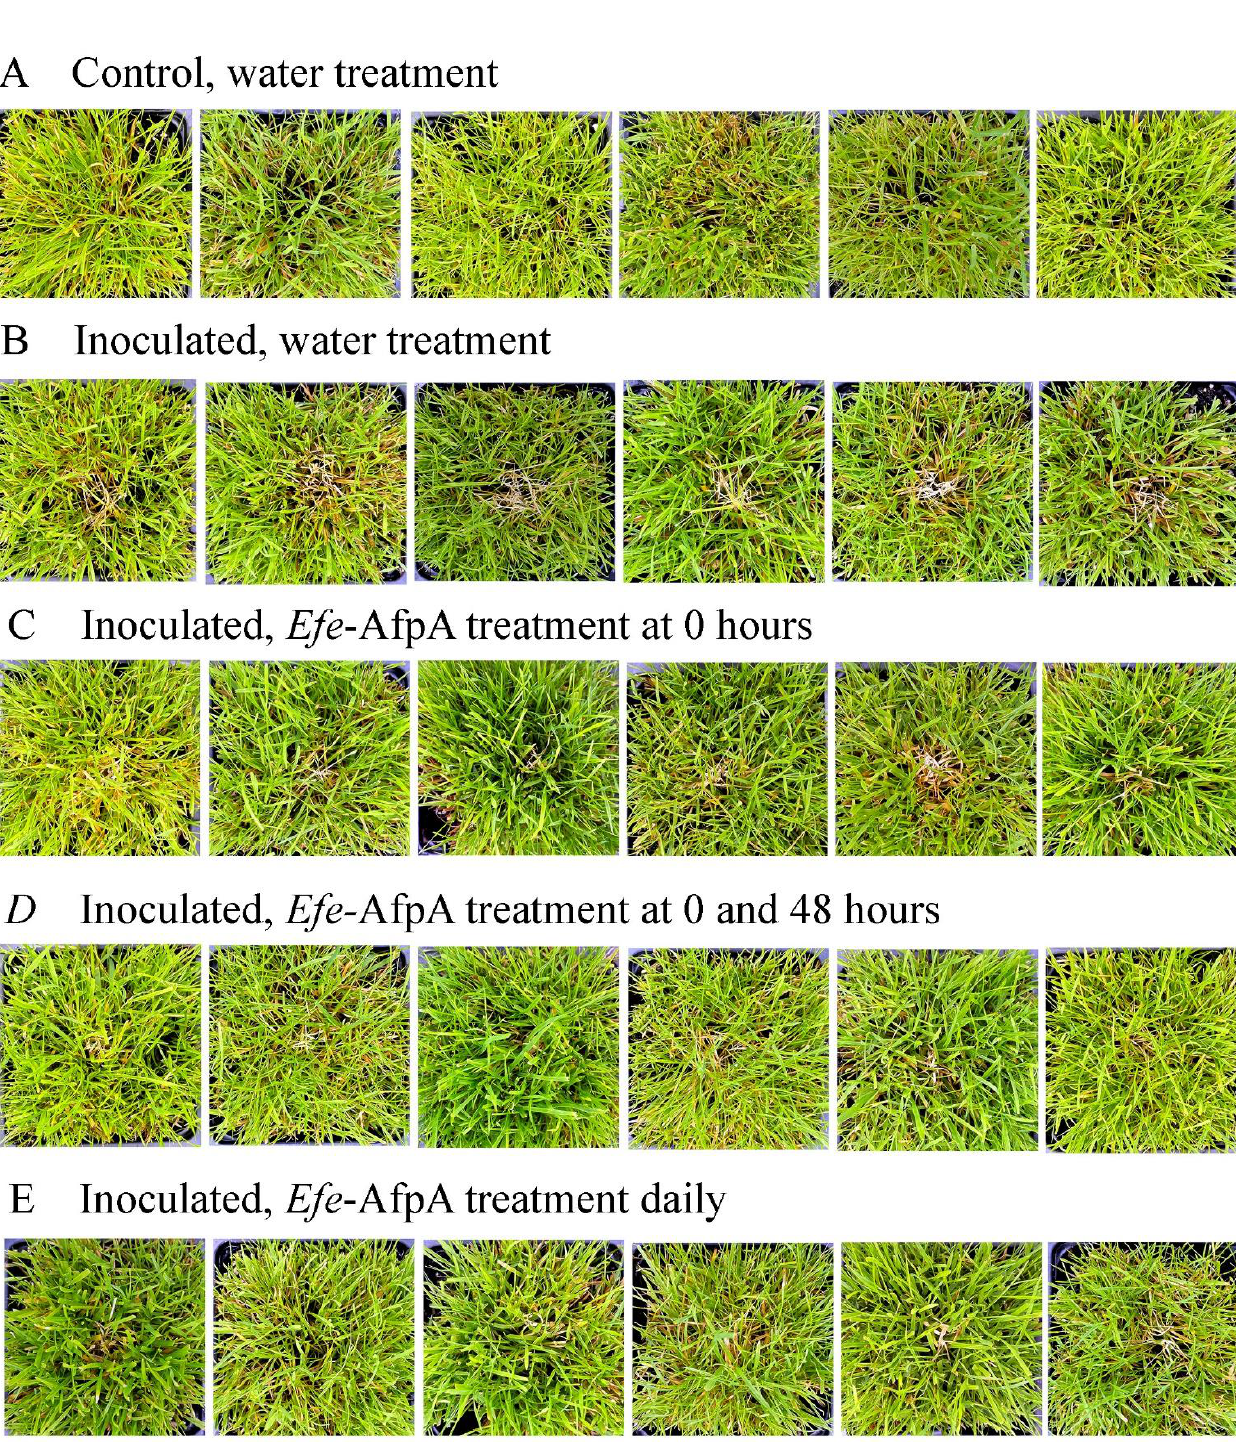
Figure 10. Effect of the number of treatments of Efe -AfpA applications on expression of dollar spot disease symptoms after creeping bentgrass cv. ‘Crenshaw’ plants were inoculated with an 8 mm plug of C. jacksonii . Plants were treated water ( A , B ) or with 100 μ g mL − 1 of Efe -AfpA as indicated ( C – E ) and photographed 7 days post inoculation. Photos within a row are replicates of the labeled treatment.